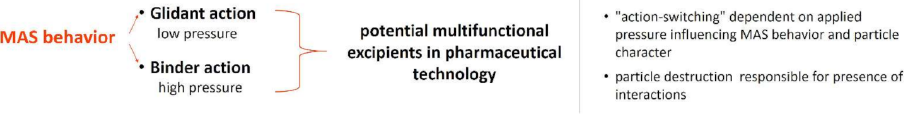
Figure 5. Graphical illustration of obtained